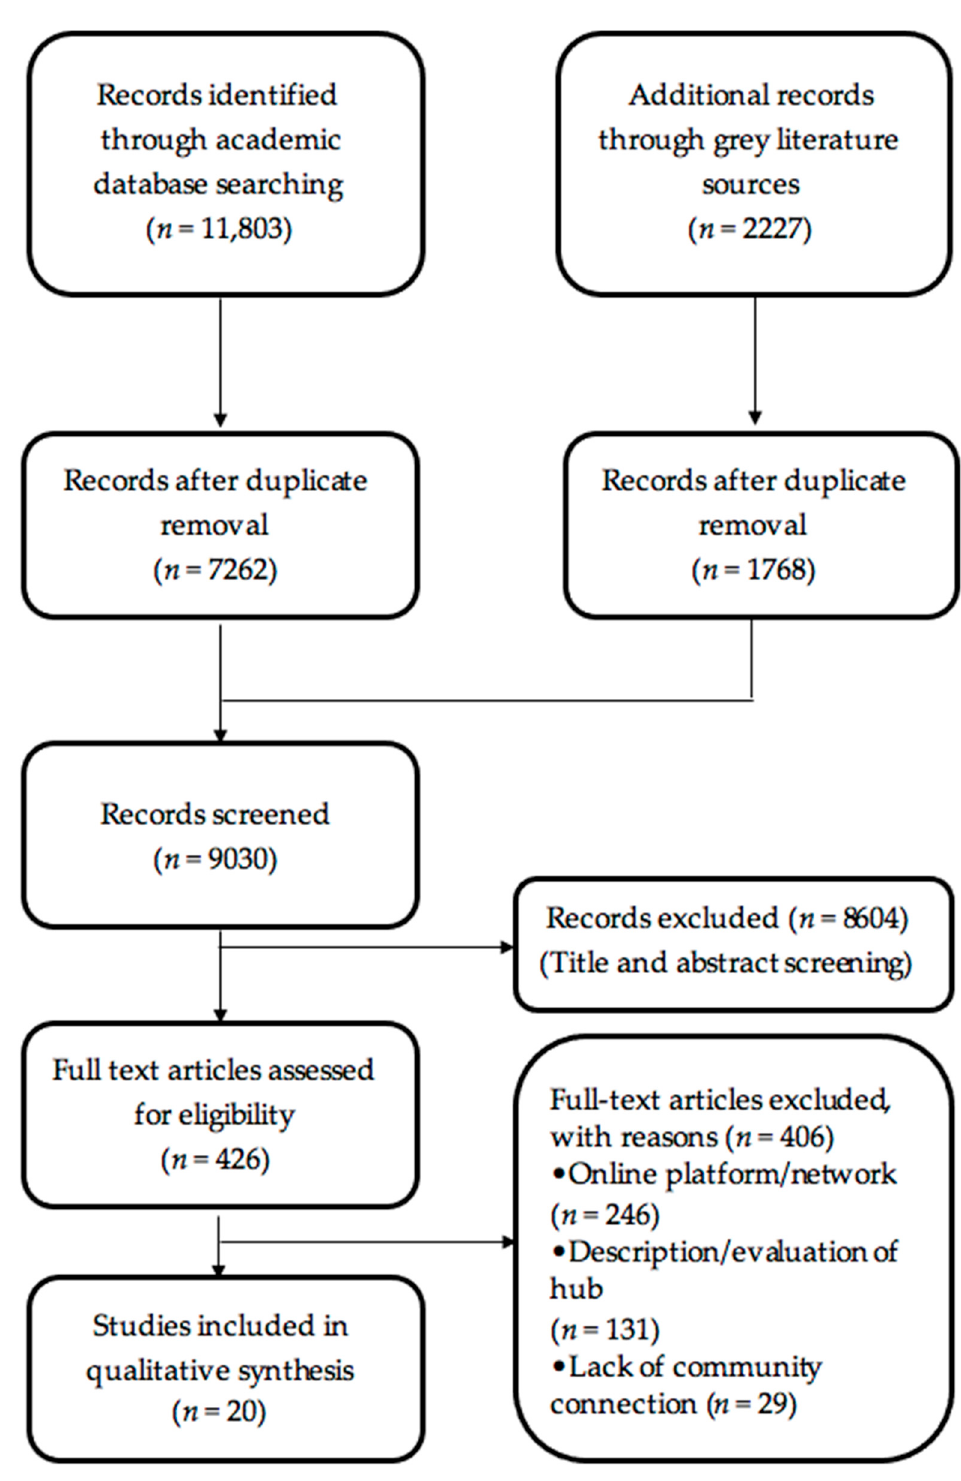
Figure 2. Preferred Reporting Items for Systematic Reviews and Meta-Analyses flowchart to track included and excluded study numbers.